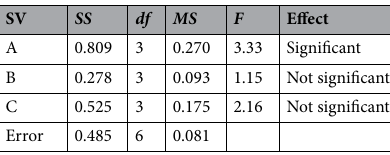
Table 9. The variance analysis of average pore diameter. F 0.01 (3, 6) = 9.78; F 0.05 (3, 6) = 4.76; F 0.1 (3, 6) = 3.29.